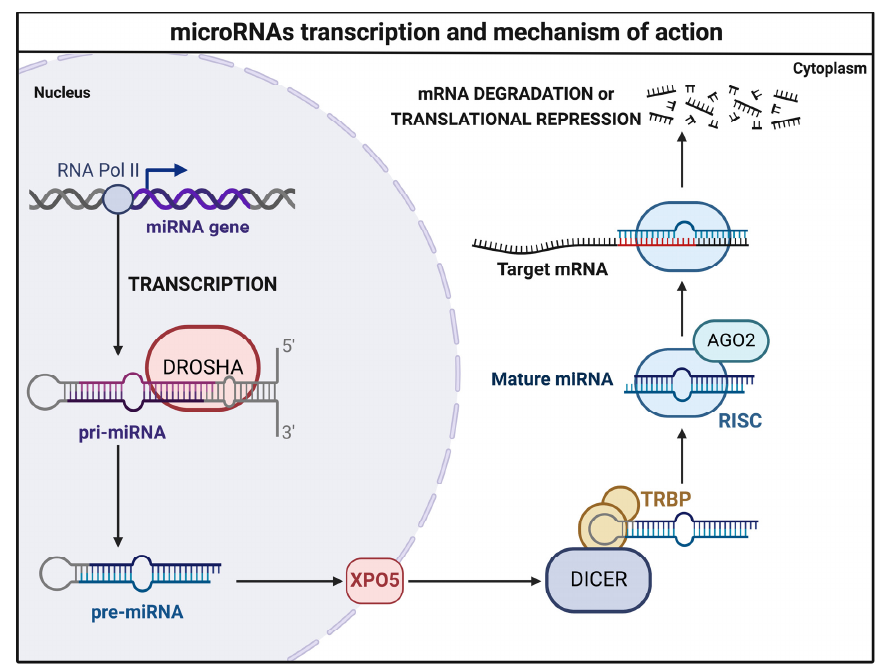
Figure 2. miRNA transcription and mechanism of action. RNA polymerase II (RNA Pol II) drives the transcription of primary microRNA (pri-miRNA) from the miRNA gene. Pri-miRNA is then